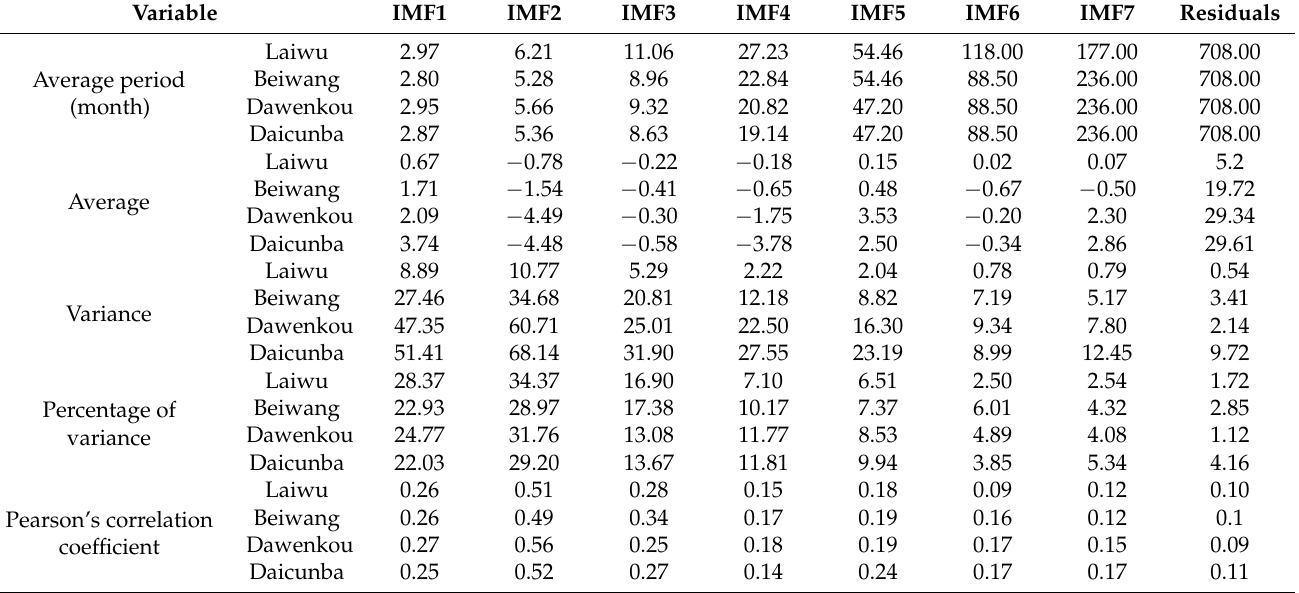
Table 3. The IMF and residue terms for the decomposed long-term runoff data.